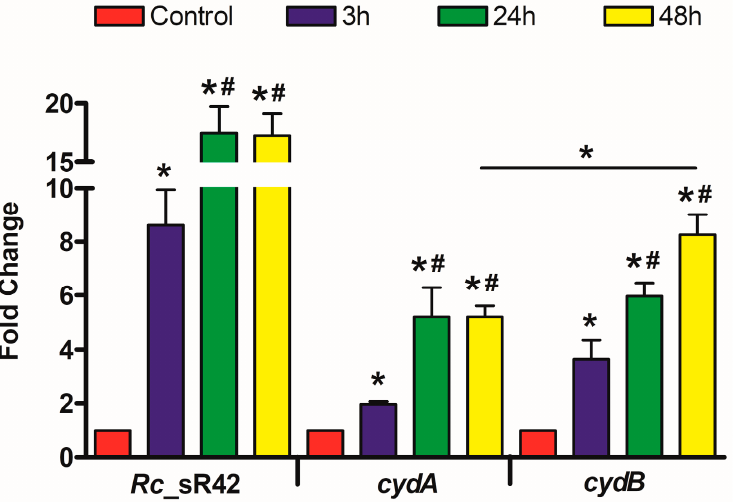
Figure 1. Expression profile of Rc _sR42 sRNA, cydA , and cydB coding transcripts in R. conorii during the infection of mouse endothelial (b.End3) cells in vitro. Significant upregulation of both sRNA and coding gene ( cydA and cydB ) transcripts was observed at 3, 24, and 48 h post-infection when compared to the control. Data are presented as mean ± SEM from three independent biological replicates. # Denotes significant changes ( p < 0.05) observed between 3 h vs. 24 h and 3 h vs. 48 h. * and/or # p < 0.05.